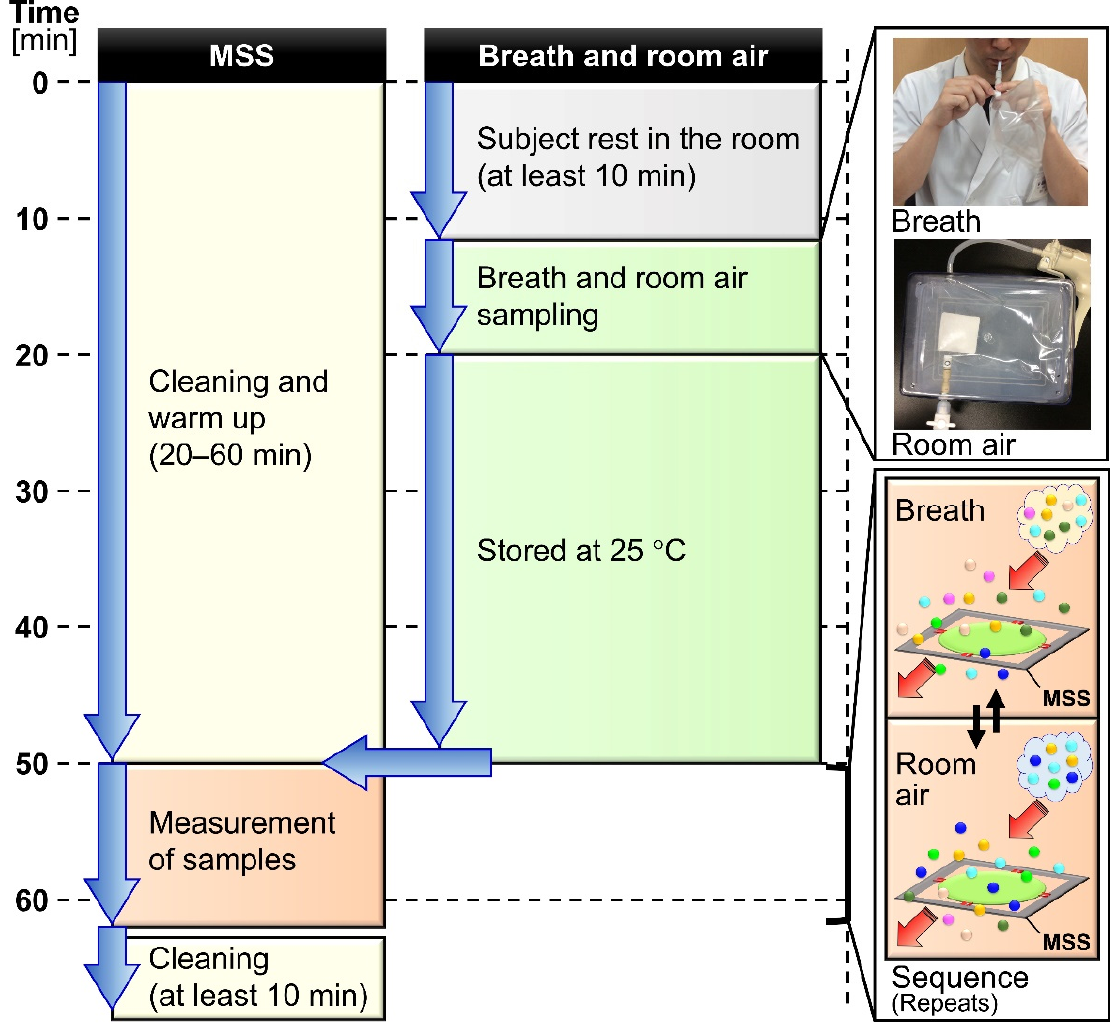
Figure 1. Flow chart of the exhaled breath assay with an outline of the protocol along the timeline. MSS stands for Membrane-type Surface stress Sensor.